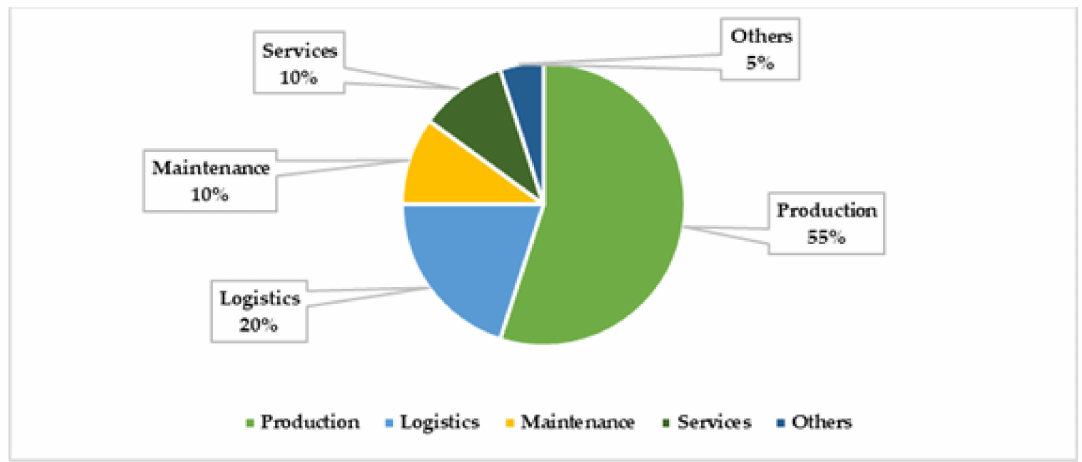
Figure 7. Areas of automation for PSA Group SVK. Source: Authors’